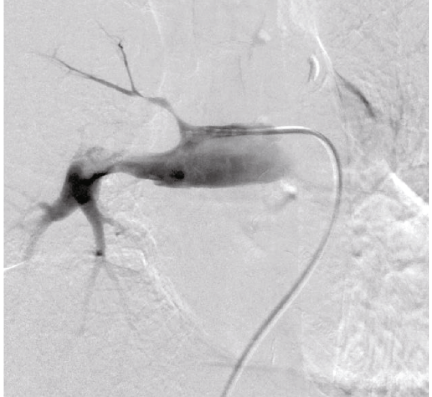
Figure 2: A pulmonary angiogram revealing tumor of the right main pulmonary artery. The catheter is attached to the fi lling defect, and vacuum suction is performed.